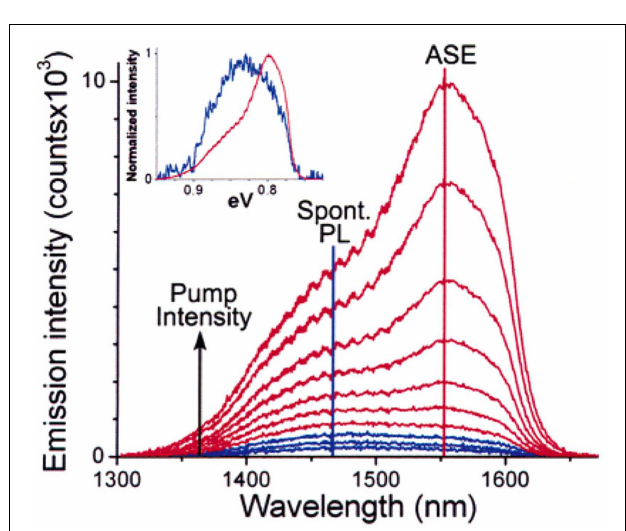
FIGURE 14 |Absorption spectra of 8.5nm (A) and 4.5nm (B) PbS QDs recorded at 12, 100, 200, and 300K (Olkhovets et al., 1998) .